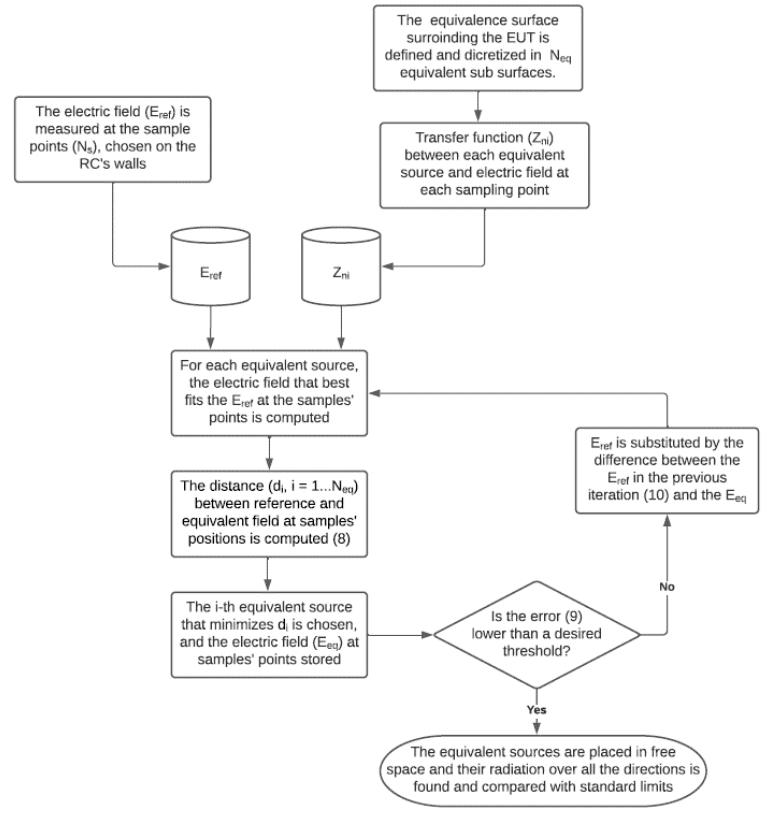
Figure 3. Flow chart of the algorithm for the reconstruction of the radiated emissions. Two set of data are required. The first one is the value of the electric field measured at the samples’ positions. The second one is the Z ni matrix that represents the analytical transfer function between each equivalent source and the electric field at sample position. Four equivalent sources are placed in each sub surface in which the whole equivalence surface is discretized.